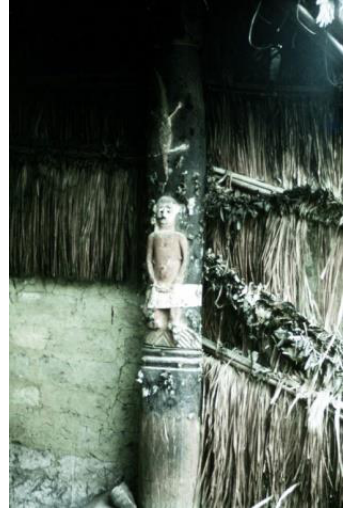
Figure 16 ii. Carved Post. Source: nairaland.com